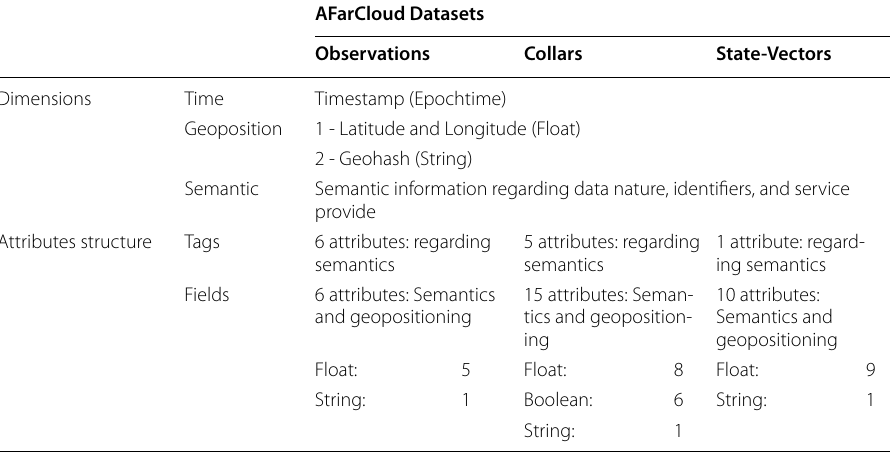
Table 3 Data model for datasets 1, 2, and 3